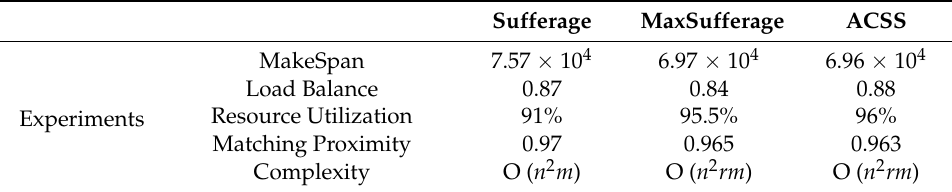
Figure 7. The ratio of Matching Proximity in all of scheduling algorithms. Table 12. The performance and complexity comparisons of all of algorithms.